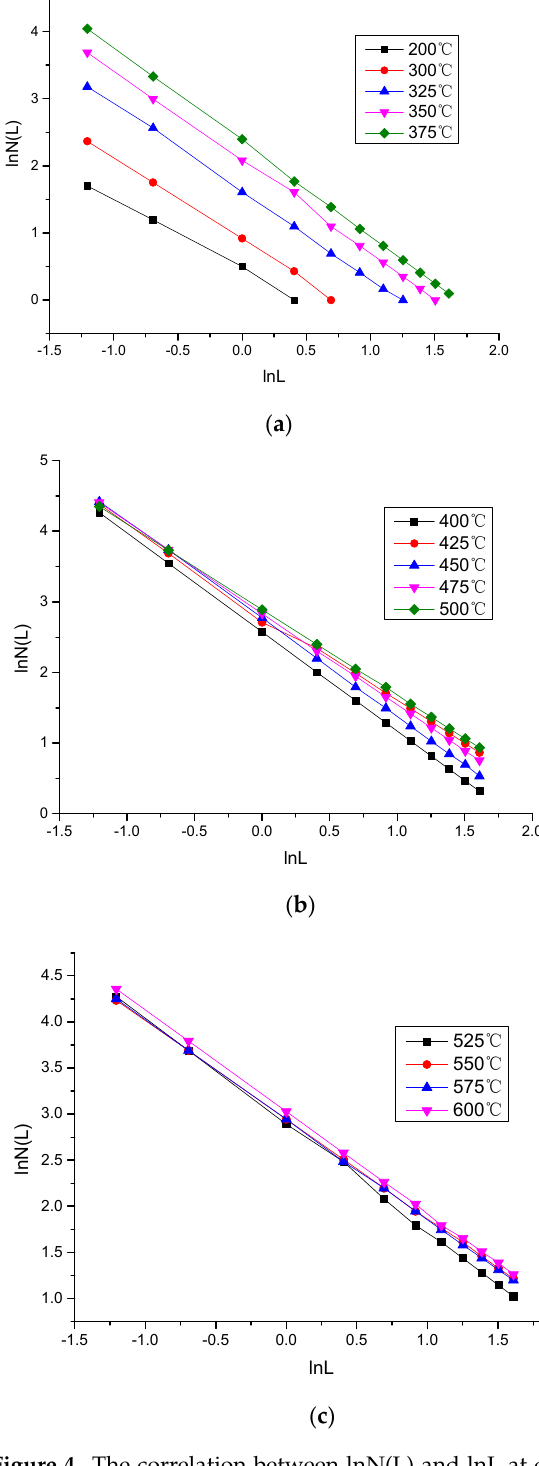
Figure 4. The correlation between lnN(L) and lnL at different temperatures: ( a ) The logarithmic relationship between the fracture number and length at temperatures of 200 °C, 300 °C, 325 °C, 350 °C, 375 °C; ( b ) The logarithmic relationship between the fracture number and length at temperatures of 400 °C, 425 °C, 450 °C, 475 °C, 500 °C; ( c ) The logarithmic relationship between the fracture number and length at temperatures of 525 °C, 550 °C, 575 °C, 600 °C. The variation of values for D (cid:2929) and n (cid:2929) is shown in Figure 5. The fractal dimension characterizes the complexity of the fracture number in different thermal conditions. More ‐ over, the initial fractal value was close to the proportion of large ‐ scale fractures, and the larger the proportion of large ‐ scale fractures, the larger the initial values. As depicted in Figure 5, from 200 °C to 600 °C, the fractal dimension increased first and then decreased with increasing temperature, thus reaching a maximum at approximately 400 °C, indicat ‐ ing that the fracture number variation of oil shale samples reached an inflection point at 400 °C. The initial value gradually increased with increasing temperature and reached an extreme value at 600 °C, indicating that the proportion of large ‐ scale cracks in oil shale was increasing and reached the maximum at 600 °C. Several factors are responsible for these relationships. From 200 °C to 400 °C, due to the combined action of thermal effect and pyrolysis chemical reaction, the fracture evolution was mainly the generation of many new cracks and enlargement of existing fractures. The fracture morphology becomes in ‐ creasingly complicated as temperature increases. Therefore, the fractal dimension and the initial value increase gradually with the increase of temperature. The temperature range of 400 °C to 600 °C was the dramatic development stage of thermal effect. The fracture